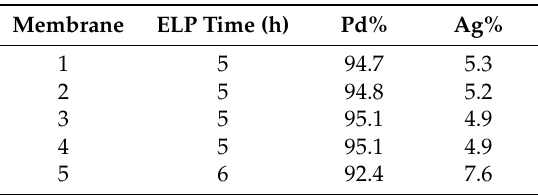
Table 2. Membranes used in this study with electroless plating time and solution composition.